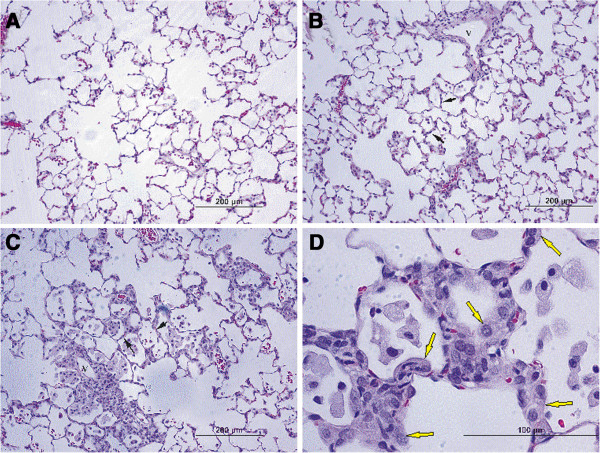
Histopathological evaluation of pulmonary injury and inflammation. Micrographs of H&E-stained tissue sections from rats 28 days after intratracheal instillation with saline (A), QD-NH2 (B), or QD-COOH (C &D). At 28 days after instillation of QD-NH2, infiltration of leukocytes around a blood vessel and in alveoli are present, with minimal thickening of alveoli septa (B, black arrows). At 28 days in the QD-COOH group, alveolar walls are thickened (C, black arrows) and alveoli contain foamy macrophages, and hyperplastic Type II epithelial cells can be found in alveoli (D, yellow arrows). V, vessel.